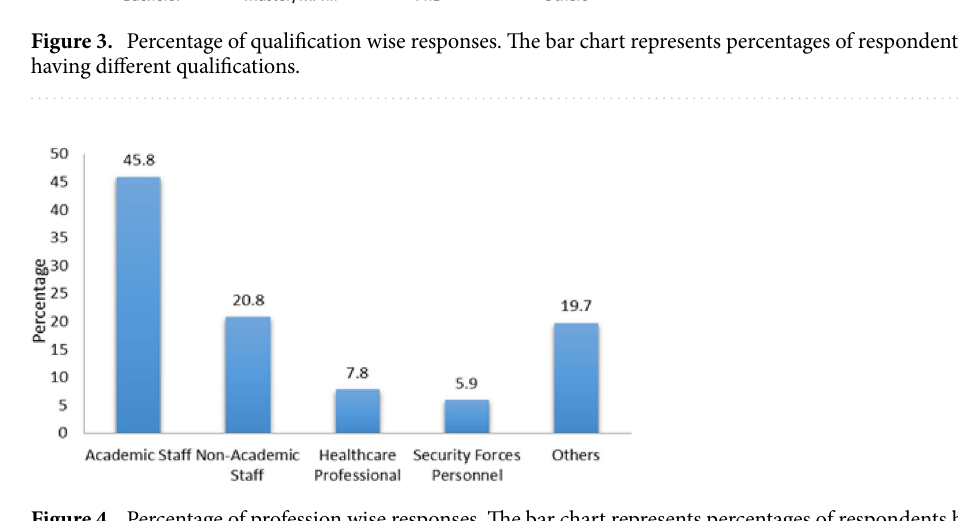
Figure 4. Percentage of profession wise responses. The bar chart represents percentages of respondents having different